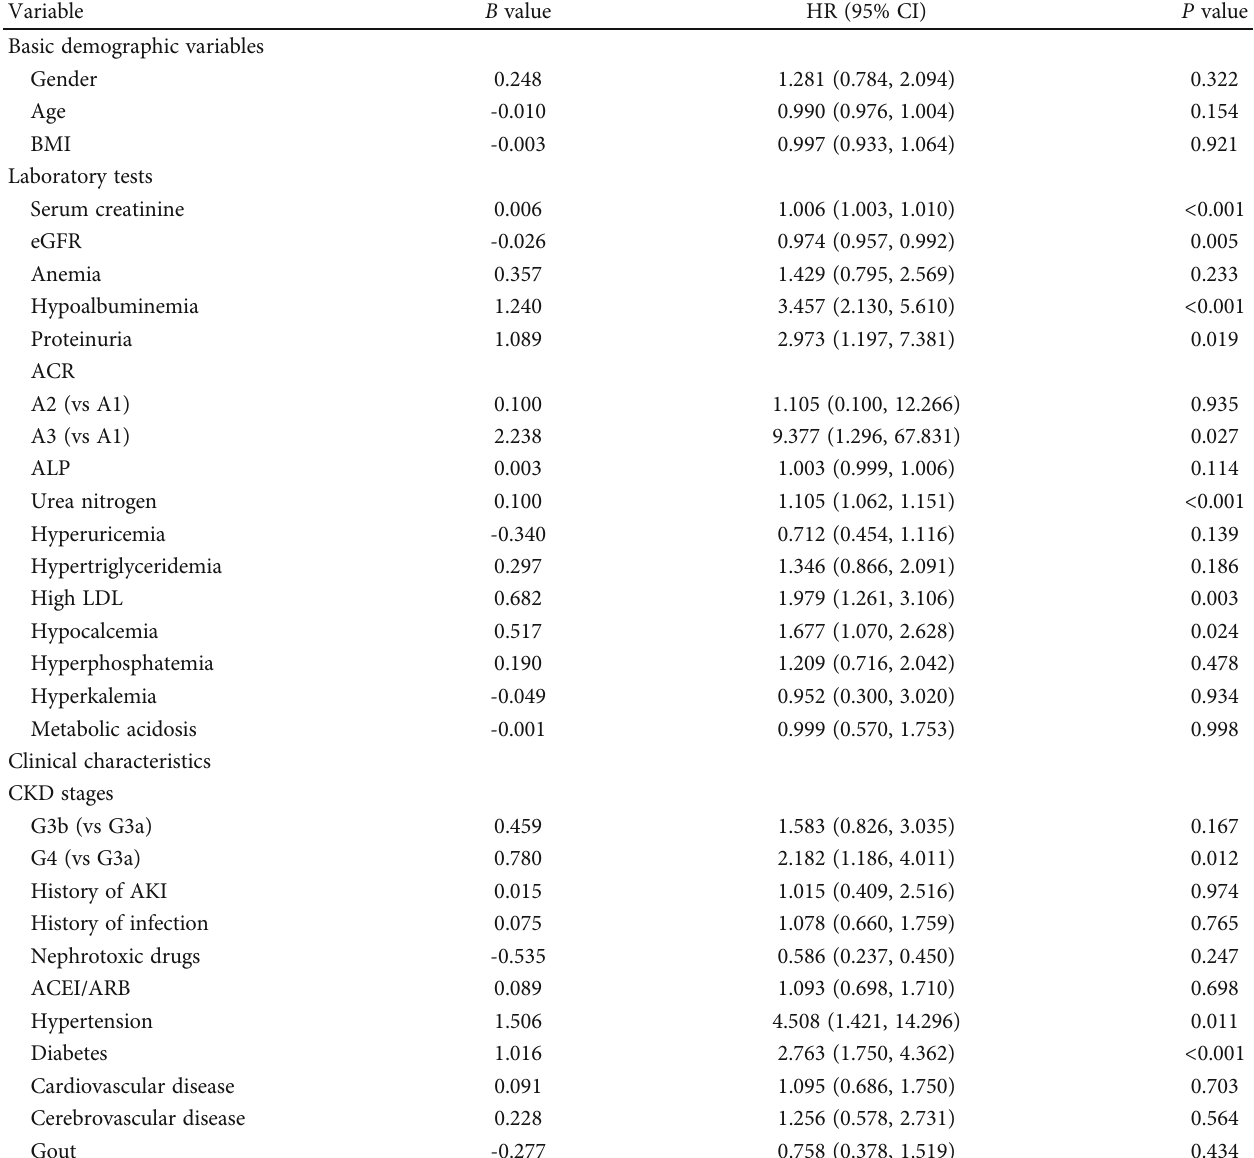
Table 3: Univariate analysis of factors a ff ecting the development of chronic kidney